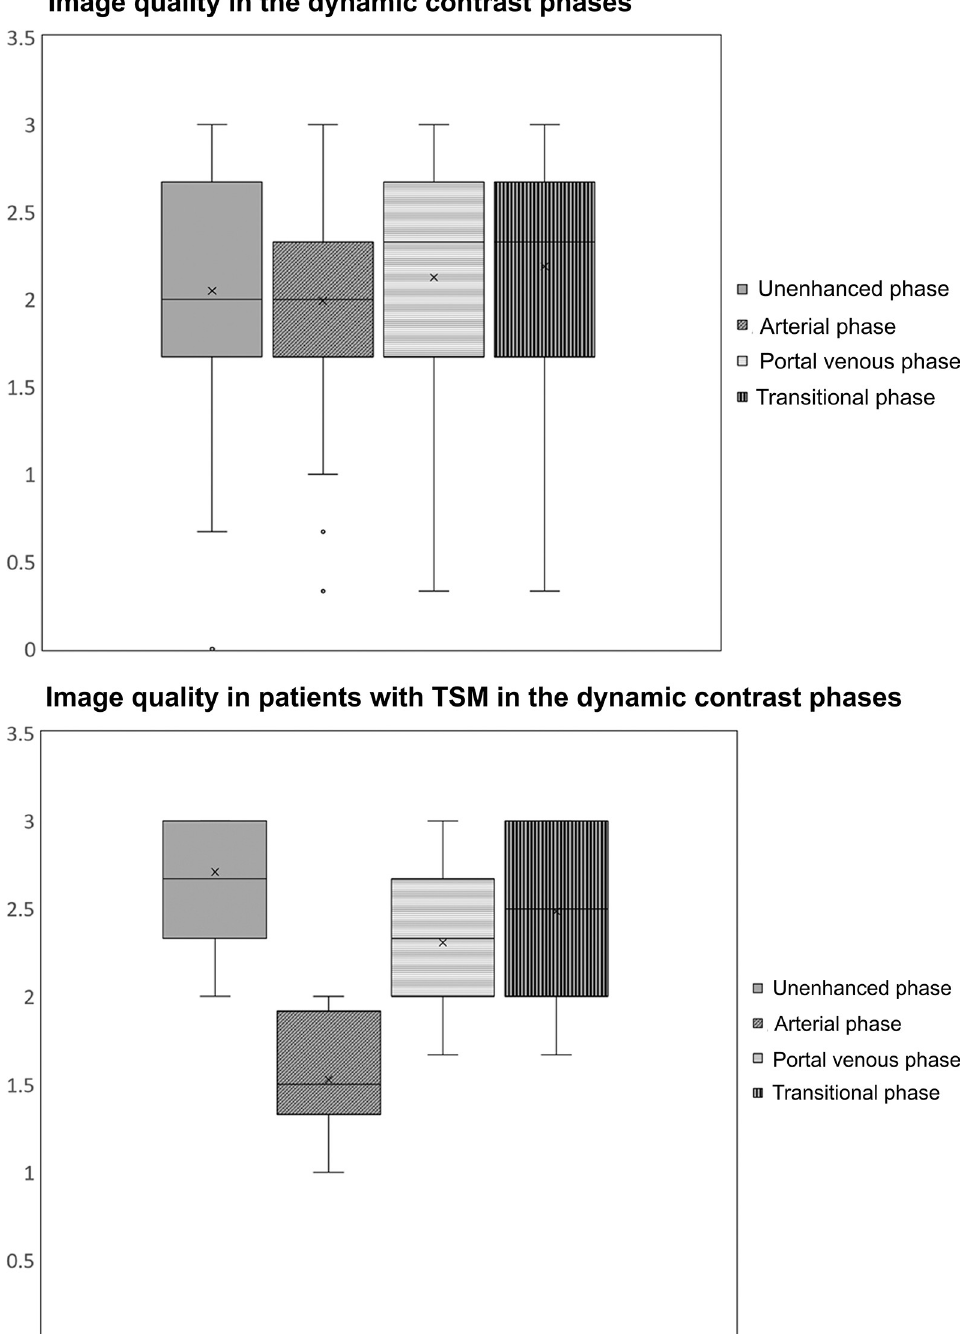
Fig 2. The image quality in the unenhanced, arterial, portal venous, and transitional phases. An image quality score of 3 indicated no artifacts, while 0 indicated non-diagnostic images due to artifacts. (2A) The image quality of the study collective and (2B) the image quality of the non-sedated patients with TSM.